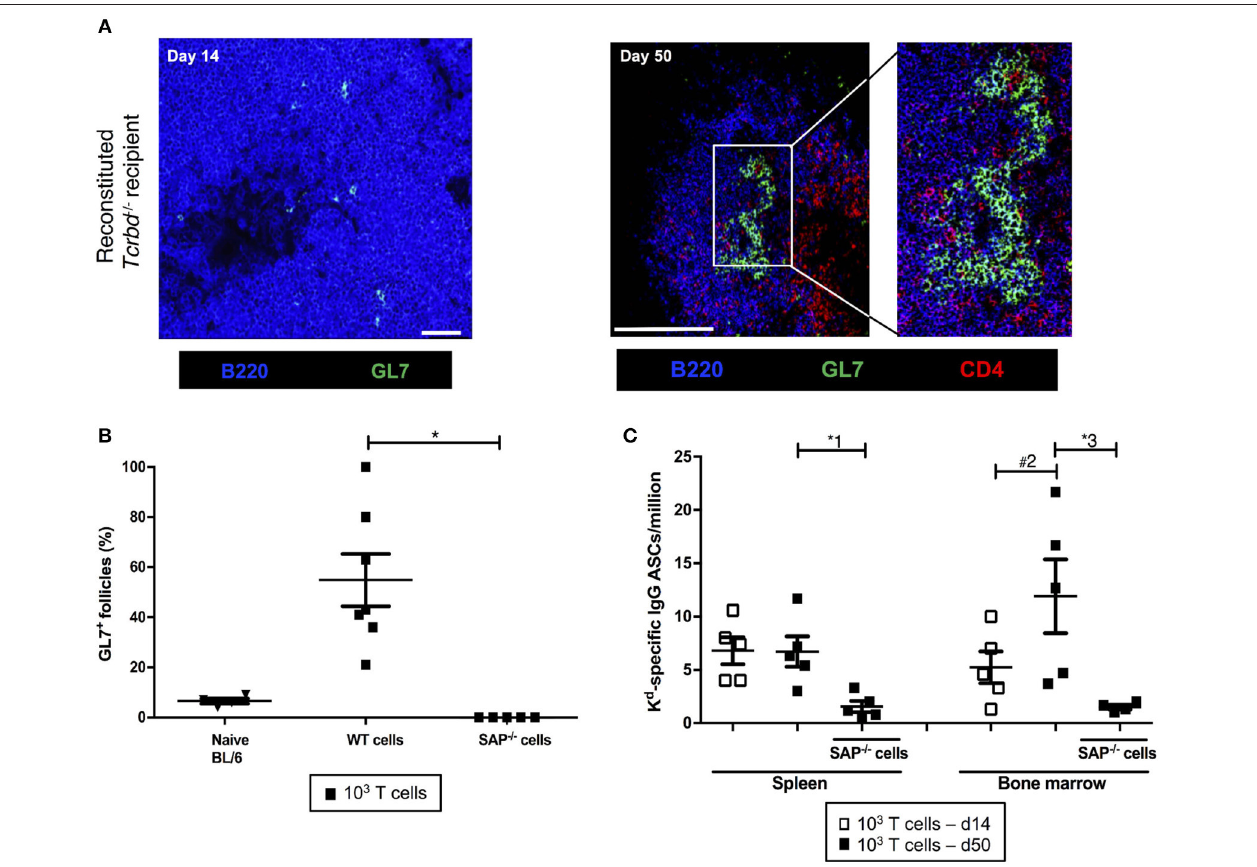
FIGURE 3 | Germinal center responses and T FH cell profile of adoptively transferred CD4T cells following challenge a BALB/c heart allograft . (A) Representative confocal immunofluorescence photomicrograph of a splenic B cell follicle at d14 (left; scale bar − 50 µ m) and d50 ( right ; scale bar − 250 µ m) from reconstituted BL/6 Tcrbd − / − recipients of BALB/c heart grafts stained with antibodies against B220 (B cells, blue), GL7 (GC B cells, green), and CD4 (T cells, red), demonstrating poorly defined GCs at d14 but by d50a typical secondary follicle, with T FH cells present within the GC (inset) , readily evident. (B) Histogram of secondary follicles expressed as percentage of total follicles within d50 spleens of BL/6 Tcrbd − / − recipients either non-reconstituted (naïve) or adoptively transferred with 1 × 10 3 WT or Sh2d1a − / − (SAP − / − ) TCR75 CD4T cells. * P = 0.01, Mann-Whitney test. (C) ELISPOT assay of splenic and bone-marrow anti-K d IgG antibody secreting cells (ASCs) 50 days after transplantation. Numbers of bone marrow ASCs in recipients reconstituted with SAP − / − TCR75 CD4T cells were not above background. Data represents mean ± S.E.M of a minimum of 5 animals/group, with each dot representing the biological replicate in a distinct animal; * 1 P = 0.02, # 2 P = 0.15, * 3 P = 0.02, Mann–Whitney